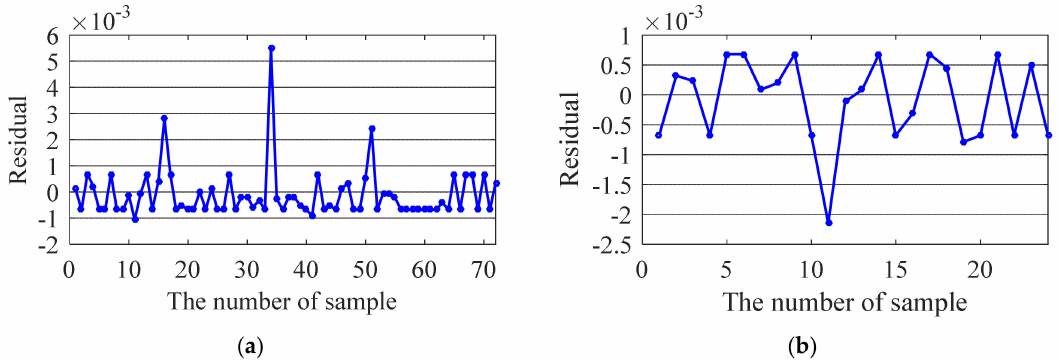
Figure 16. Residual of the third modal frequency: ( a ) Training sample; ( b ) Testing sample.